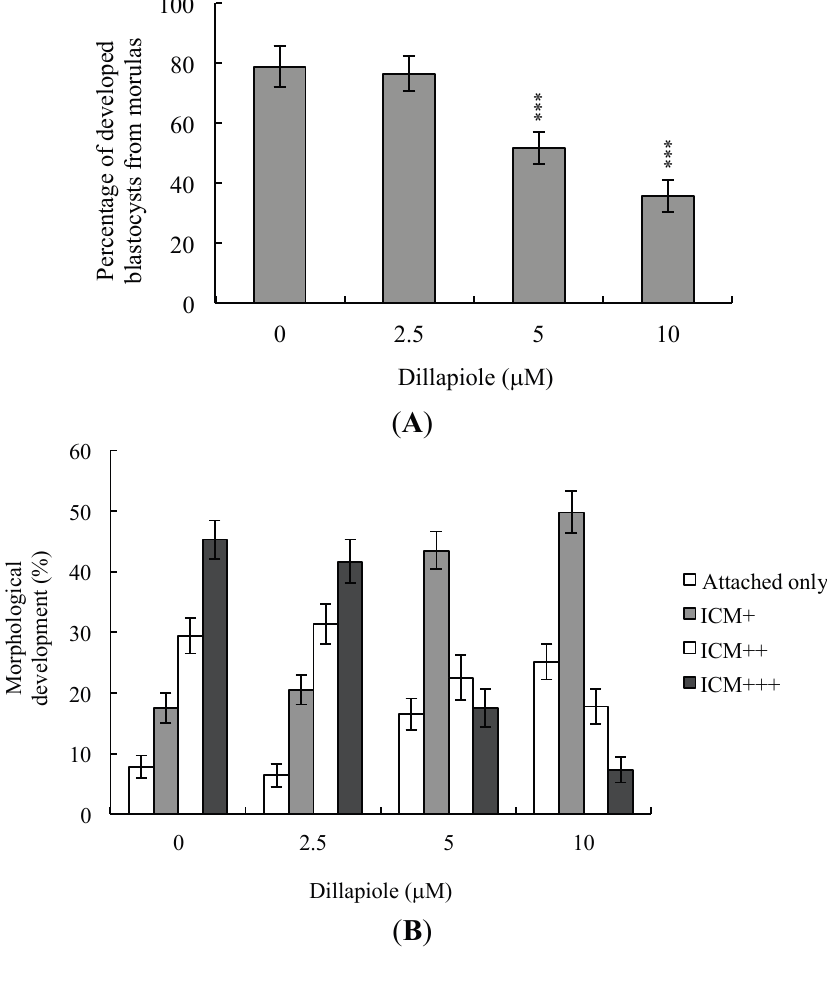
Figure 3. In vitro development of mouse embryos exposed to dillapiole at the blastocyst stage. ( A ) Mouse morulas were treated with dillapiole (2.5, 5, or 10 μ M) or left untreated for 24 h and cultured for an additional 24 h at 37 °C. Blastocysts were counted and percentages calculated; ( B ) Mouse blastocysts were treated with dillapiole (2.5, 5, or 10 μ M) or left untreated for 24 h, and cultured for seven days post-treatment. Blastocysts were classified as attached only, ICM+, ICM++, and ICM+++, based on morphological assessment, as described in Materials and Methods. Data are based on at least 200 blastocyst samples from each group and presented as means ± SEM of ten determinations. *** p < 0.001 versus the control